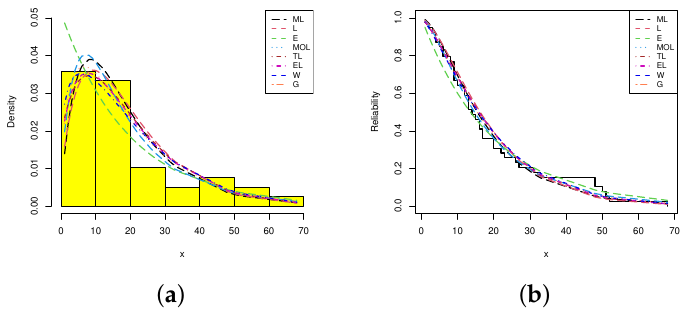
Figure 9. ( a ) Histograms/fitted PDFs; ( b ) empirical/fitted RF plots from MVAD data. Presently, to discuss the derived point and interval estimators of δ , R ( t ) and h ( t ) , three different PT-IIC samples with size m = 20 are generated from the complete MVAD data and presented in Table 8. From Table 8, the MLEs, MPSEs, and Bayes estimates with their St.Es of δ , R ( t ) and h ( t ) (for t = 2) are computed and listed in Table 9. Moreover, two-sided